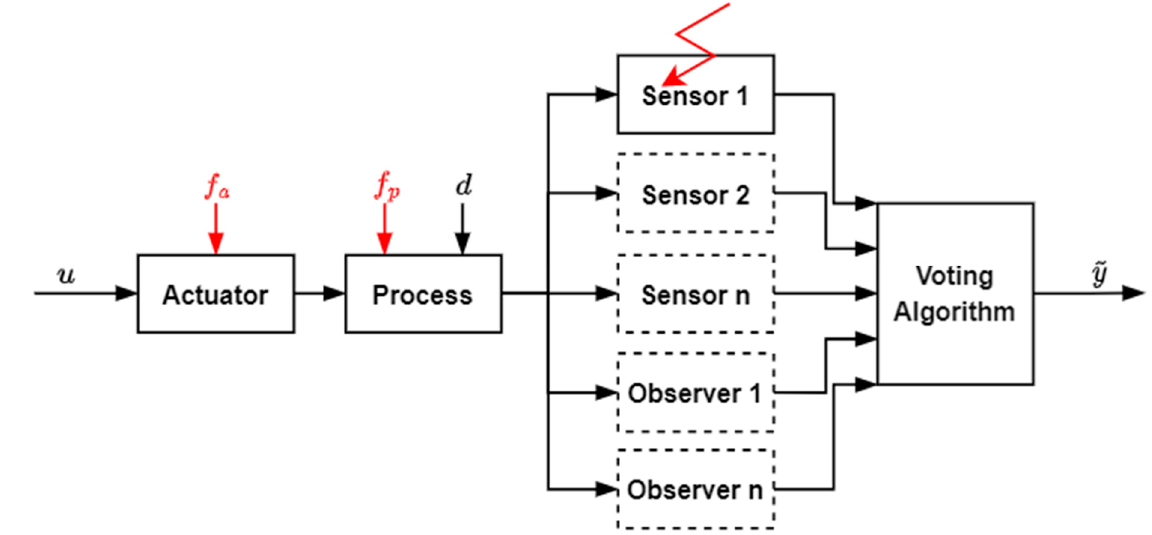
Figure 8. Scheme for hardware and software redundancy.